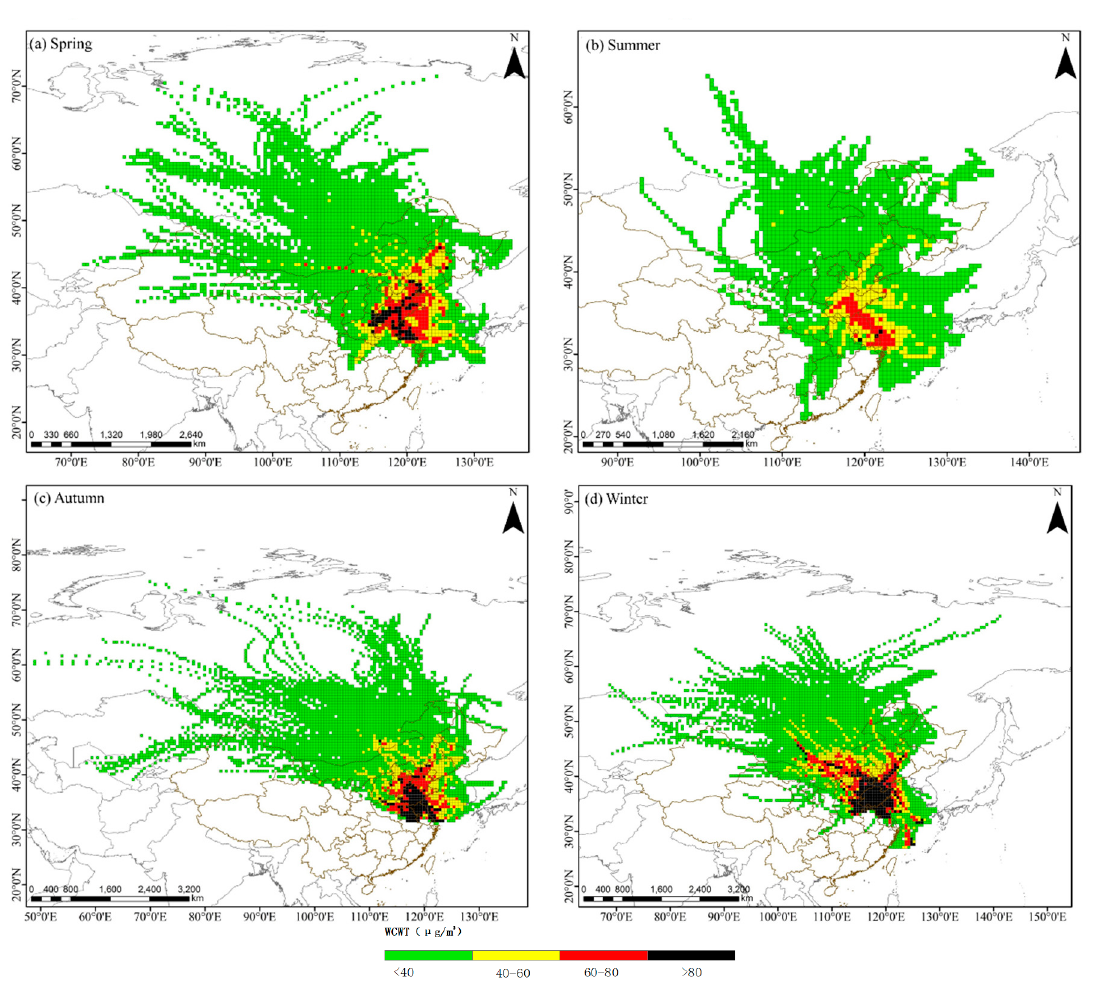
Figure 6. Spatial distribution of WCWT values of PM 2.5 in spring, summer, autumn, and winter from March 2015 to February 2016.